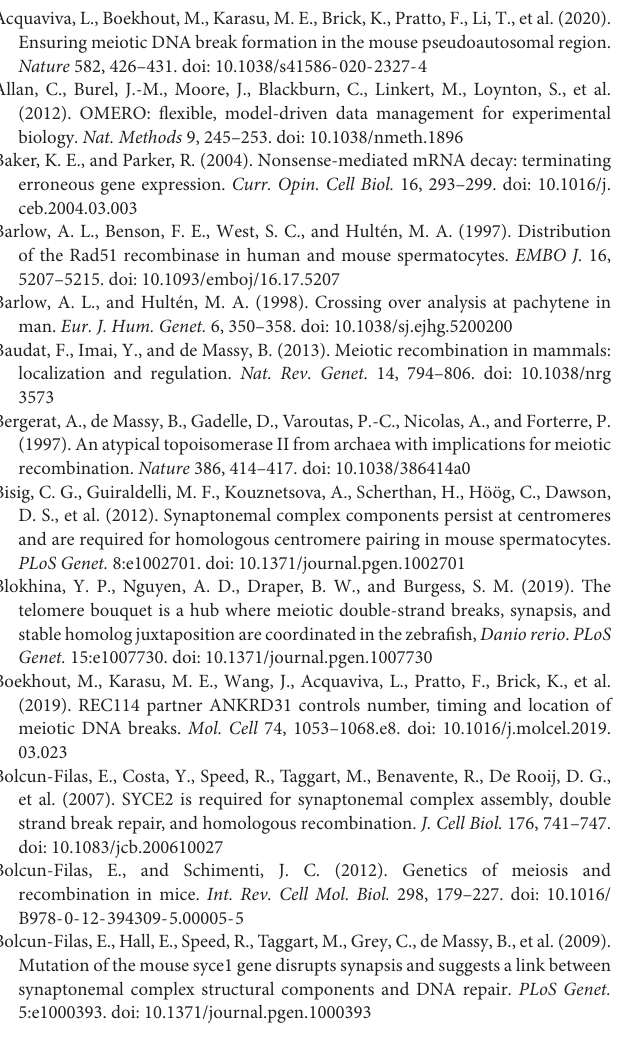
indicate means. Statistical significance was examined by a two-tailed Mann-Whitney test ( ∗ P < 0.1, ∗∗∗ P < 0.001, ns, not significant; exact P value). Supplementary Figure 6 | Generation of antibodies against zebrafish Hormad1 and Iho1. (A) Western blotting of wild-type testis protein extracts with anti-zebrafish Hormad1 antisera obtained from five immunized mice (M1 to M5), unimmunized mouse serum (Ctrl) and no-serum control (2nd Ab only). The blot image is superposed with a binary image of colorimetric capture of molecular ladders (in blue). The band indicated with a red arrowhead is close to the predicted size of the full-length Hormad1 protein (41 kDa). Each well was loaded with 50 µ g protein. M1 serum was used for immunostaining in this study (red). (B) Western blotting of protein extracts from Iho1 + / + and Iho1 − / − testes with anti-zebrafish Iho1 antisera obtained from immunized mice. The predicted size of the full-length Iho1 protein is 61 kDa, and the band specific to the Iho1 + / + sample is indicated with a red arrow. Each well was loaded with 50 µ g protein. (C) Coimmunostaining of Iho1 and Sycp3 on Iho1 + / + and Iho1 − / − spermatocyte spreads. Iho1 signals were barely observed in Iho1 − / − spermatocytes. Supplementary Table 1 | List of primers used in this study. Supplementary Table 2 | List of antibodies used in this